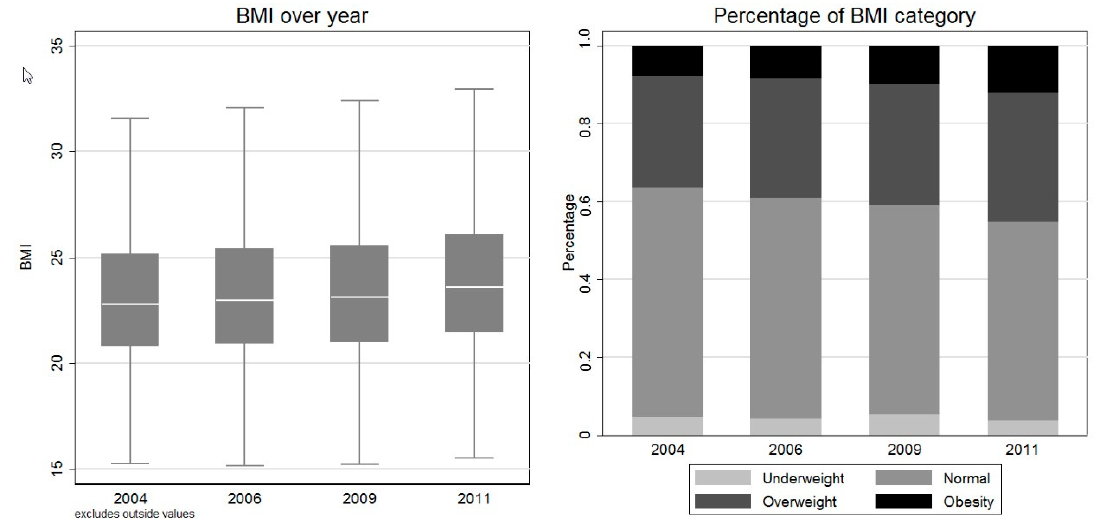
Figure 2. Changing BMI over year. Note: The box in the left panel is the 75% and 25% percentiles, and the white line within the box is the median value. Two gray horizontal lines refer to the upper and lower adjacent values. The upper adjacent value = 75th percentile + 1.5 × (75th percentile − 25th percentile), and the lower adjacent value = 25th percentile − 1.5 × (75th percentile - 25th percentile). Outside values, which are defined as those greater than the upper adjacent value or smaller than the lower adjacent value, are excluded from the box graph.